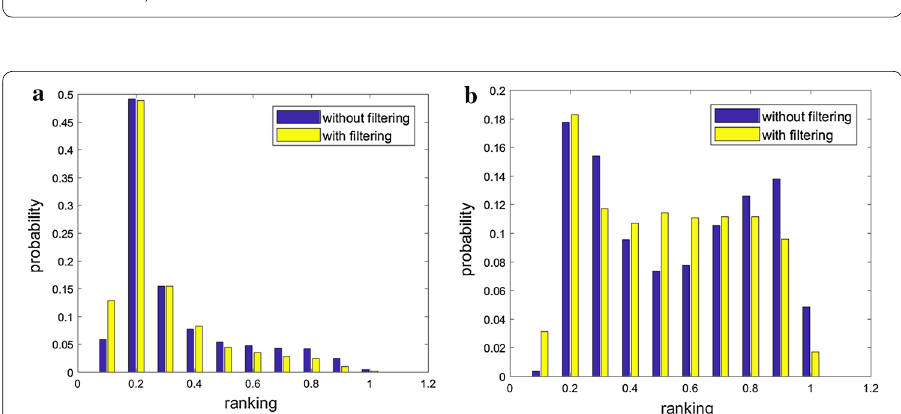
Fig. 4 Actual ranking distribution for testing labels with label 0 and 1 respectively (DES-LA combiner, German